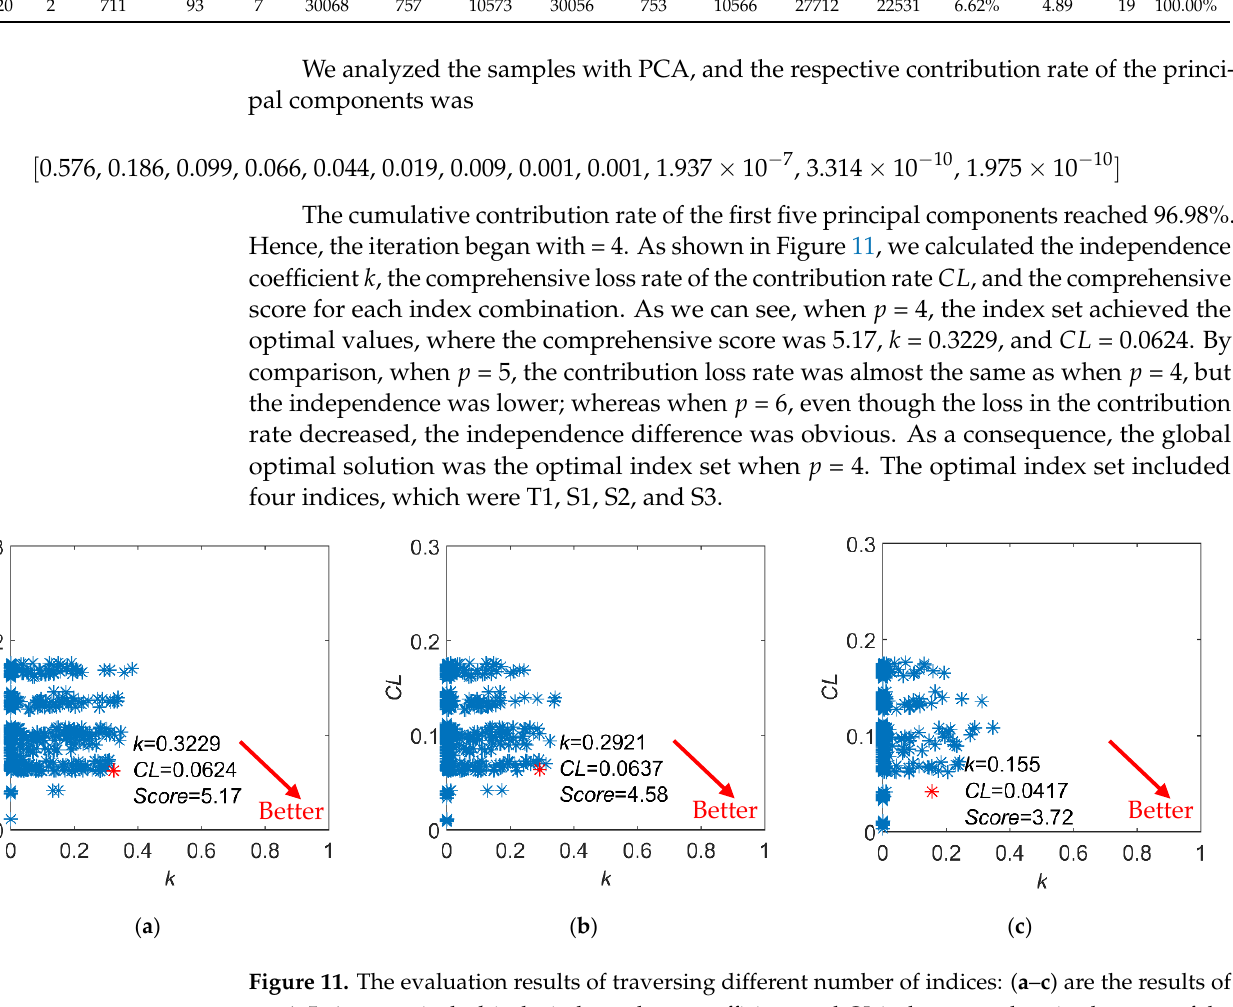
Table 5. Comparison results of different index sets.